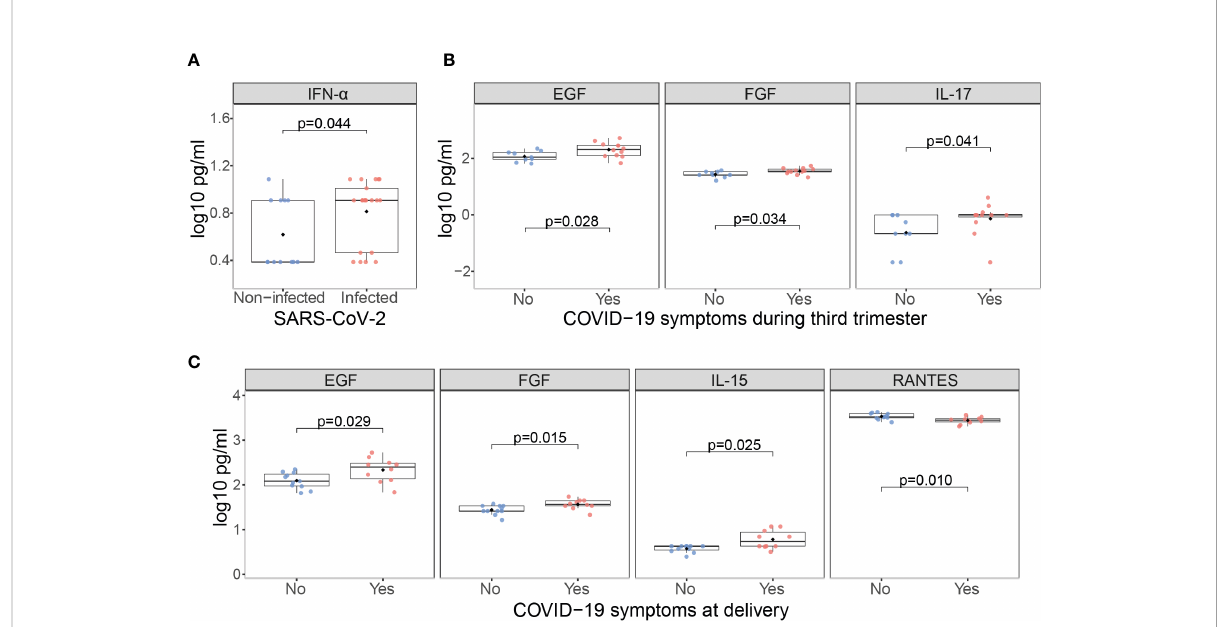
FIGURE 7 Cytokine, chemokine and growth factor concentrations in cord blood from children born from SARS-CoV-2 infected mothers. Comparison of in fl ammatory markers concentrations (log 10 pg/ml) in cord blood between (A) Infected (N=21, in red) vs. non-infected (N=12, in blue) mothers; (B) Infected symptomatic (N=12, in red) vs. asymptomatic (N=9, in blue) mothers during the third trimester; (C) Infected symptomatic (N=11, in red) vs. asymptomatic (N=12, in blue) mothers at delivery. Groups were compared by the Wilcoxon-rank-sum-test. Only signi fi cant comparisons are shown, the remaining are in Figures S9 –